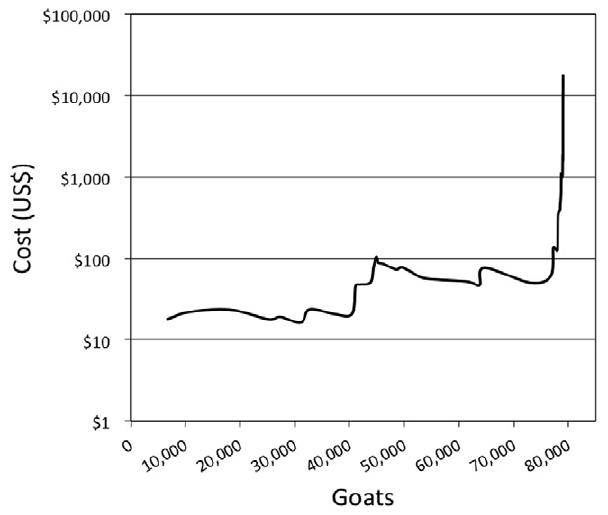
Figure 1. The marginal cost curve of removing goats from Santiago Island, Gala´pagos (2001–2006). The majority of the 79,569 goats removed cost between US $ 10–100 per goat to remove. The final goats, however, cost over $ 10,000 per goat. Technologies and tools targeted at cost-effectively removing the final animals of an eradication campaign could deliver in substantial savings to island restoration programs.